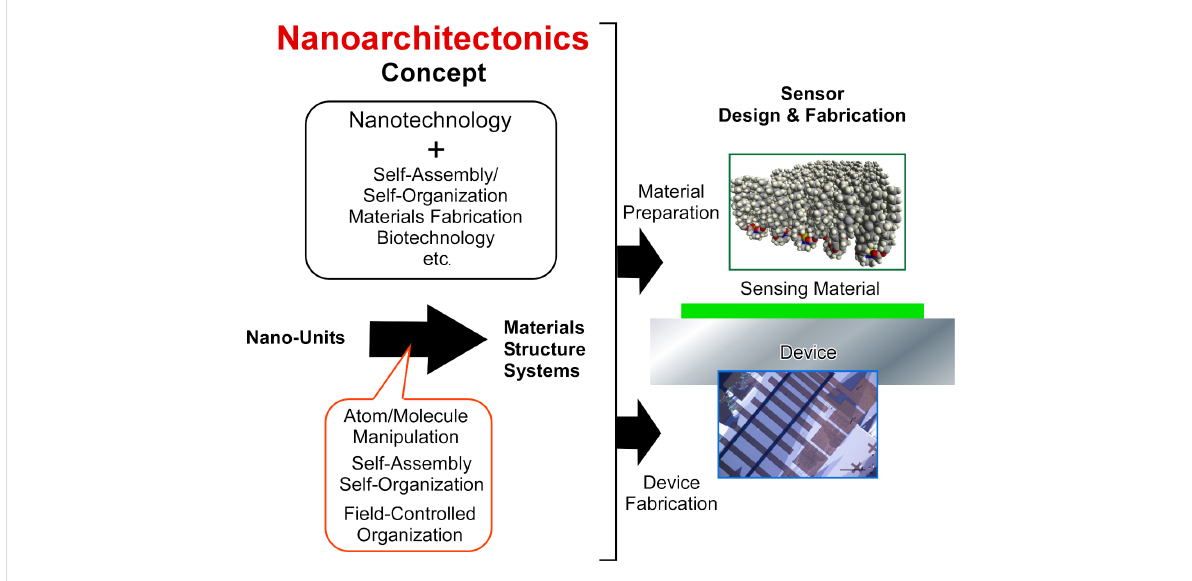
Figure 1: Outline of the nanoarchitectonics concept and its contributions to sensor design and